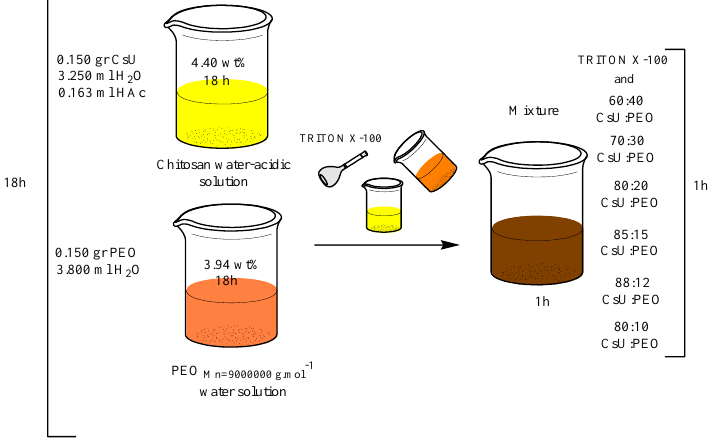
Scheme 2. Schematic representation of the ESP solutions preparation